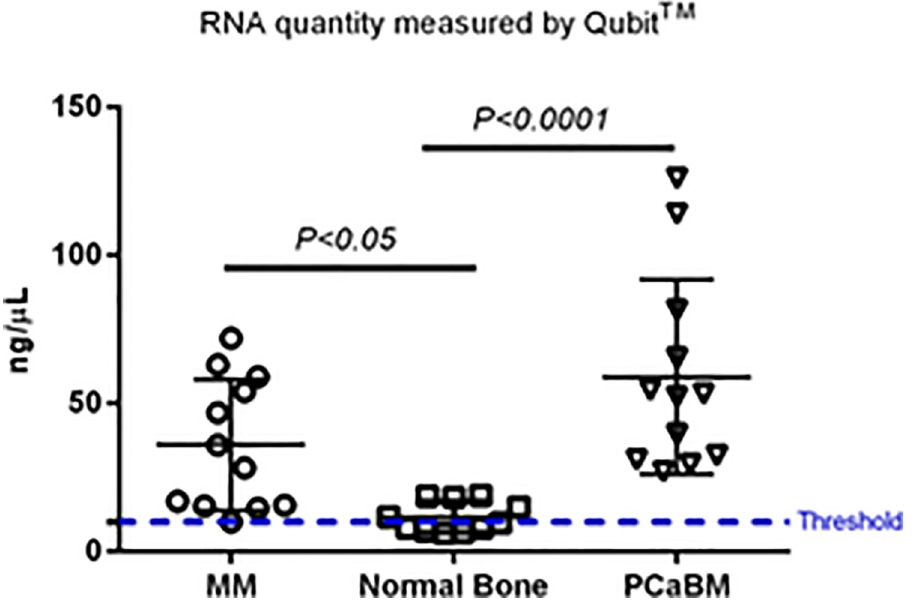
Fig 4. Quantification of mRNA yield from DFFPE of MM, normal bone tissue and PCaBM tissue using Qubit TM . Scatter-dot plot indicating quantification of mRNA concentration yield from DFFPE of MM, normal bone tissue and PCaBM tissue using Qubit TM 2 Fluorometer. p < 0 . 05 and p < 0 . 0001 for comparison, n = 12. Data were analyzed by 1-way ANOVA test and shown as means ± SD. Threshold line indicated the minimum required mRNA concentration (~10 ng/ μ L) for gene expression assay by NanoString TM